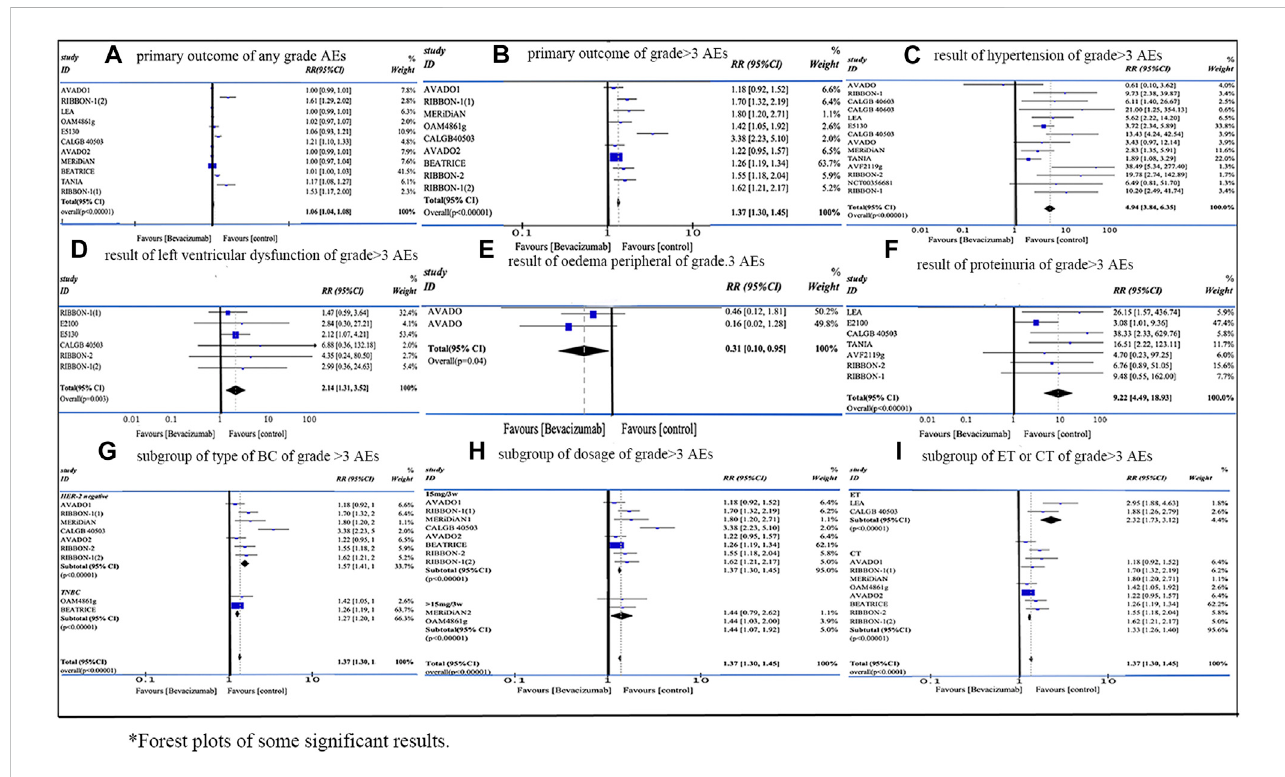
FIGURE 2 Forest plots of signi fi cant